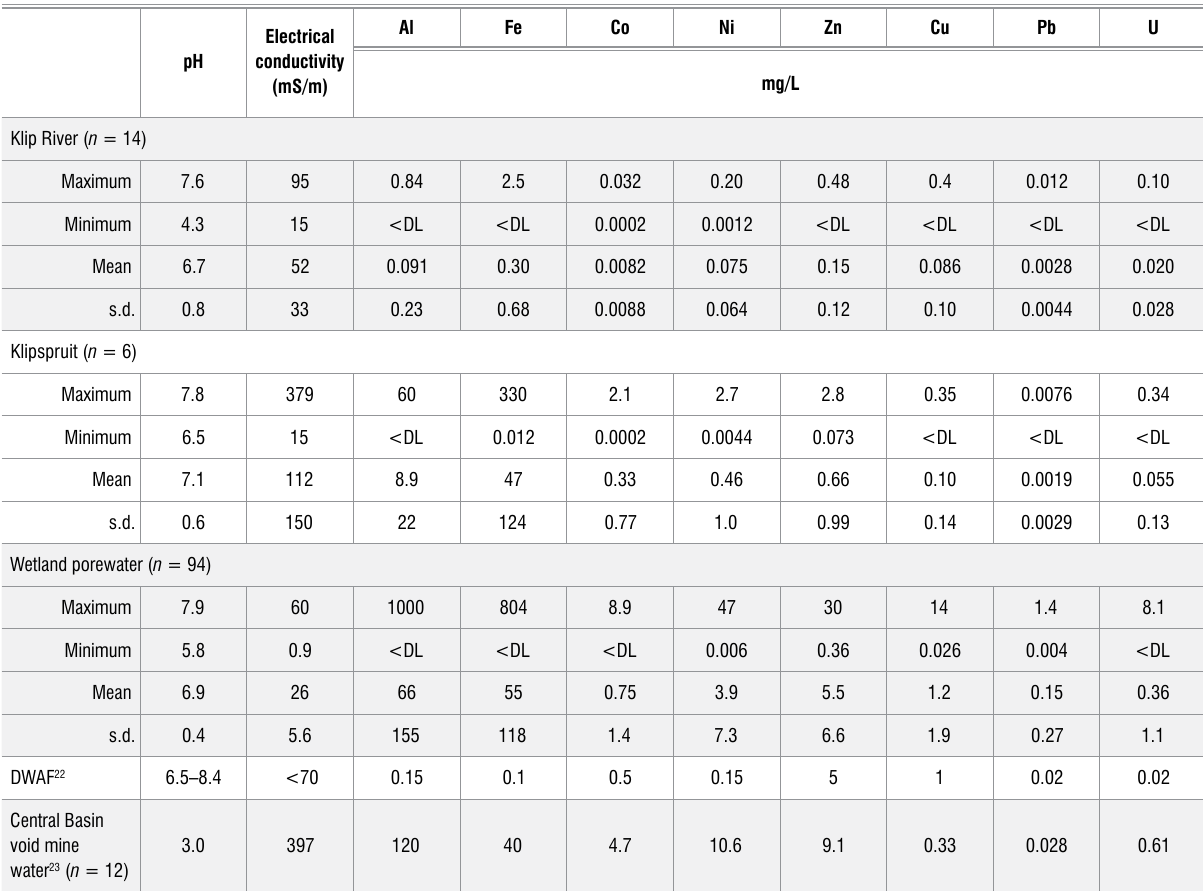
Table 1: Chemistry data for surface water catchment samples and porewater samples from the Klip River wetland